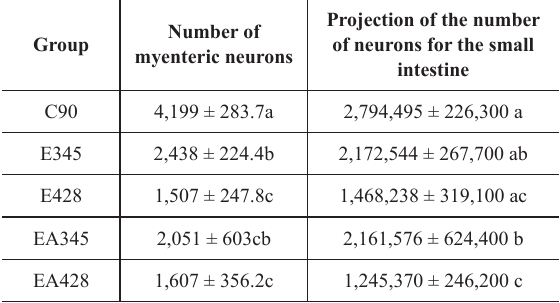
Number of myosin-V immunoreactive myenteric neurons quantified in 14.8 mm 2 of duodenum of rats at different ages: C90 days, E 345 days, E428 days, and with ascorbic acid supplementation: EA 345 and EA 428 days (n = 5). Data were expressed as mean ± standard deviation (n = 5 animals/group).